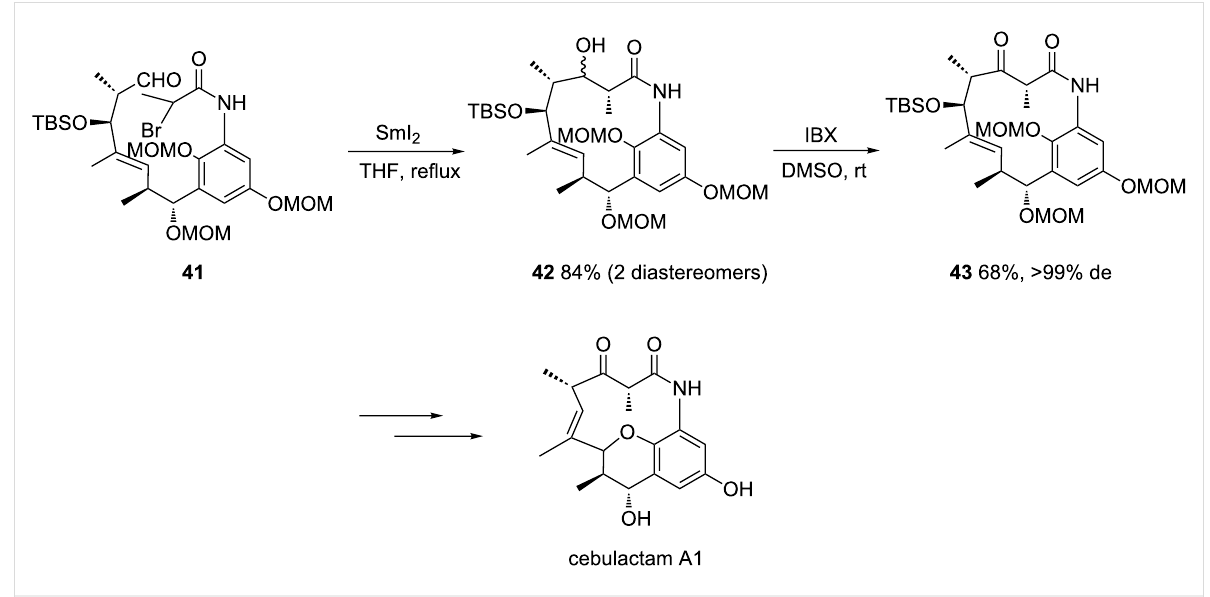
Scheme 17: Synthesis of cebulactam A1 through a Sm(II)-mediated Reformatsky reaction. MOM = methoxymethyl [34].